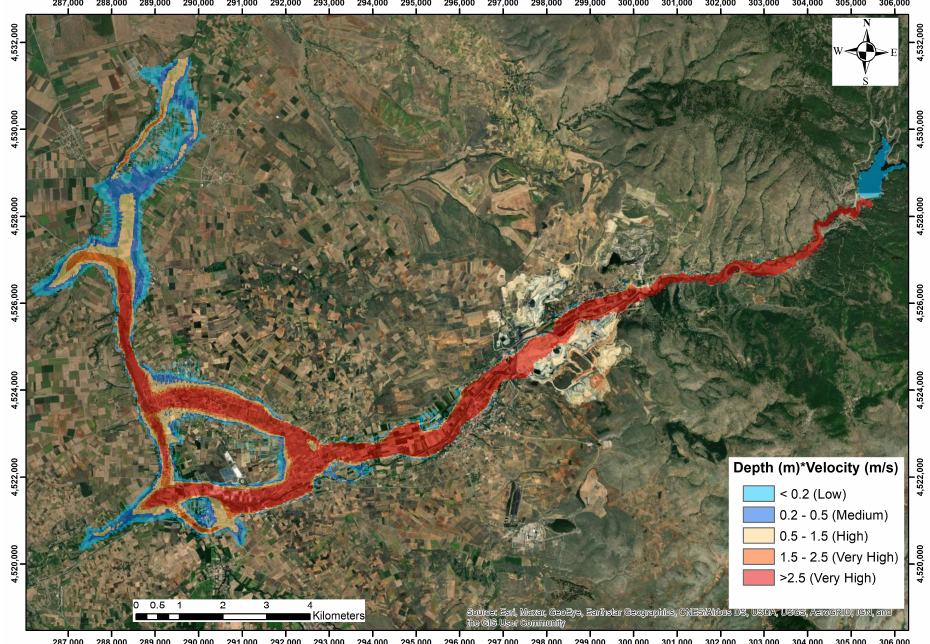
Figure 18. Flood hazard maps for the piping dam failure scenario (fist classification approach). Table 10. Flood severity classes for the product of water depth and velocity and the inundated area per class (first classification approach).